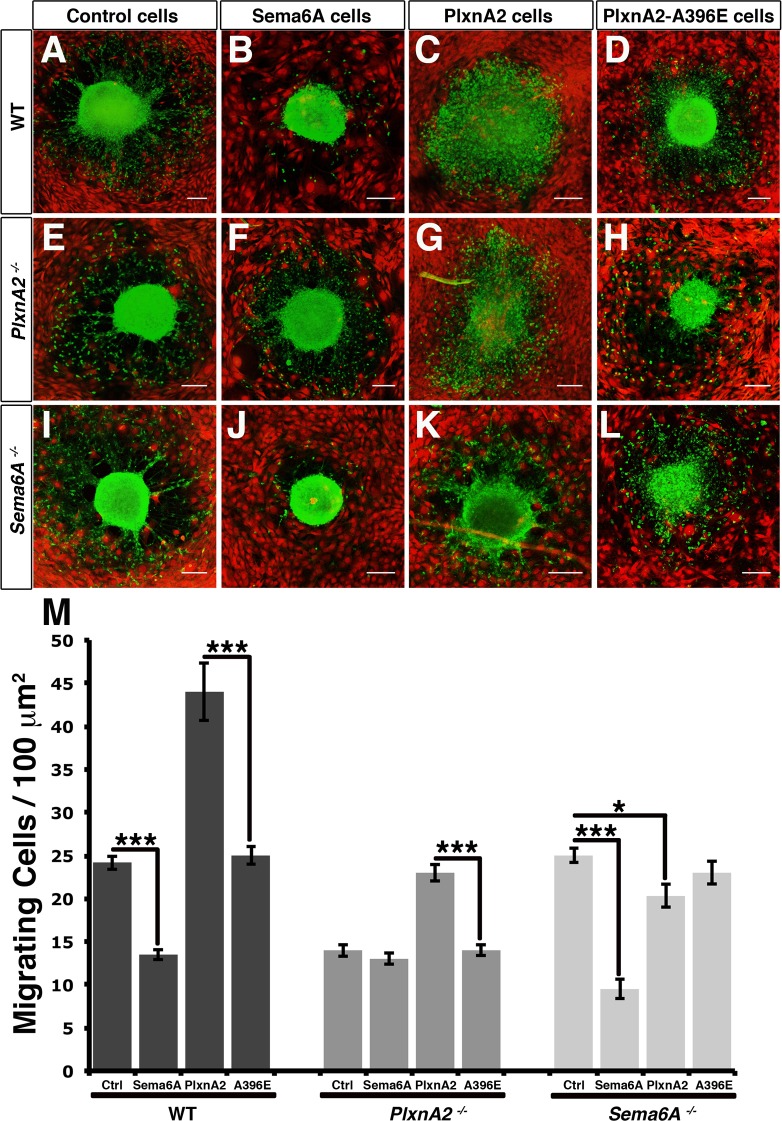
Forward and reverse Sema6A-PlxnA2 interactions have different effects on the migration of cerebellar neurons.(A-L) EGL explants of WT (A-D), PlxnA2-/- (E-H), and Sema6A-/- (I-L) mice cultured on a monolayer of NIH3T3 cells expressing dTomato alone (Control cells), or together with Sema6A-FL (Sema6A Cells), PlxnA2-FL (PlxnA2 Cells) and PlxnA2-A396E (PlxnA2-A396E Cells). Migrating granular neurons are visualised in green and NIH3T3 cells in red. Scale bar = 100 μm. (M) Graph summarising the migration of different EGL explants cultured together with different NIH3T3 layers; n = 50–100 explants per experimental condition. Data are expressed as mean ± s.e.m; *P < 0.05, **P ≤ 0.005 and ***P < 0.001; ***P < 0.001; one-way ANOVA followed by Bonferroni multiple comparison test.